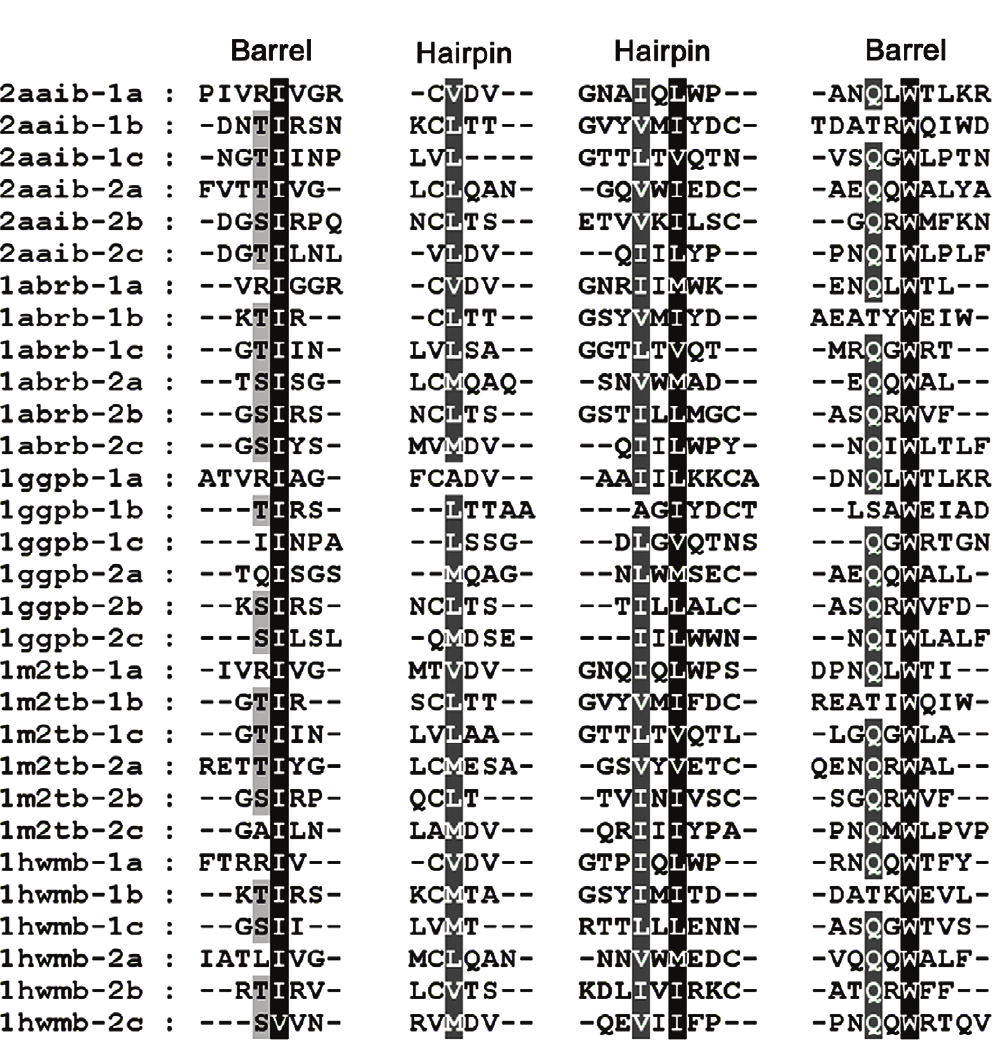
PLoS ONE | www.plosone.org 4 November 2010 | Volume 5 | Issue 11 |